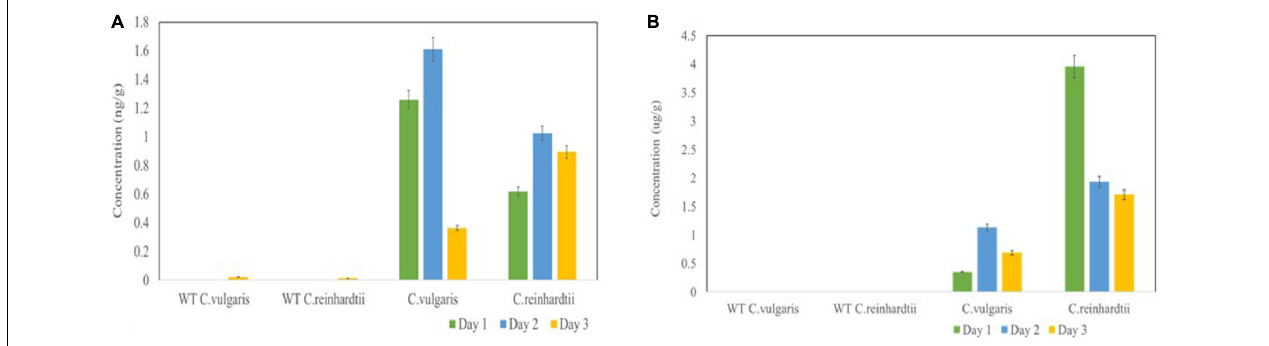
FIGURE 5 | Expression levels of bFGF (A) and SARS-CoV-2 (B) in microalgal species was measured by ELISA. Microalgal species were transformed with Agrobacterium harboring the expression vector and the samples were collected on Day 1, 2, 3 and the expression was analyzed. The result was presented on the fresh weight (FW) basis. The data are expressed as mean ± standard deviation of two biological replicates with each sample taken in